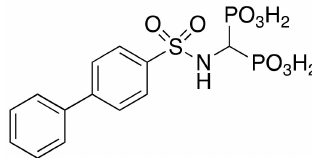
Figure 1. Chemical structure of inhibitor ML